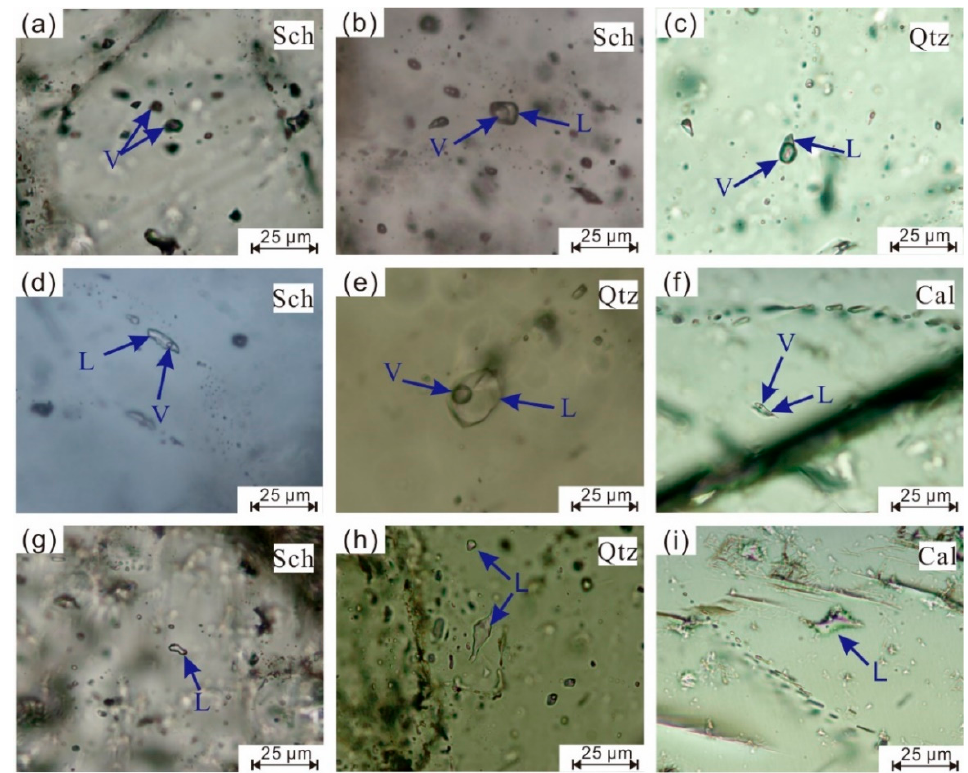
Figure 6. Photomicrograph of different fluid inclusions found in scheelite, quartz, and calcite from the Shangfang tungsten deposit. ( a ) monophase vapor (V) inclusions in scheelite; ( b , c ) aqueous liquid (L-V) inclusions in scheelite and quartz; ( d – f ) vapor-rich aqueous (V-L) inclusions in scheelite, quartz and calcite; ( g – i ) liquid aqueous (L) inclusions in scheelite, quartz, and calcite. Abbreviations: L = liquid; V = vapor; Sch = scheelite; Cal = calcite; Qtz = quartz.